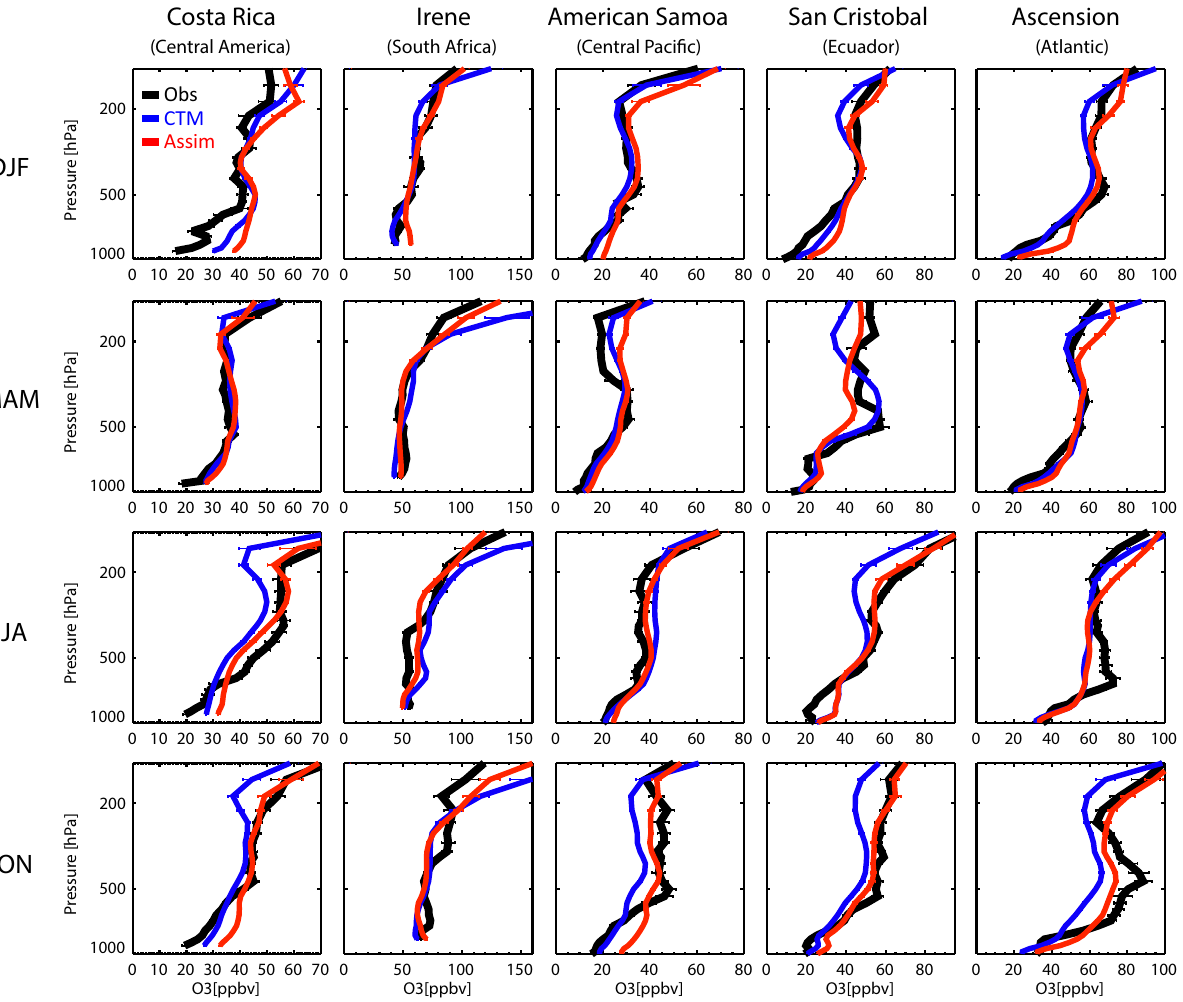
Fig. 10. Vertical O 3 profiles (in ppbv) obtained from ozonesondes (black), the CTM simulation (blue), and the data assimilation (red) for Costa Rica (left panels), Irene in South Africa (2nd from left panels), American Samoa (center panels), San Cristobal in Ecuador (2nd from right panels), and Ascension in the tropical Atlantic (right panels) during December–February (DJF, top row), March–May (MAM, 2nd from top row), June–August (JJA, 2nd from bottom row), and September–November (SON, bottom row) in 2007. The error bars represent the standard deviation of all the data within one